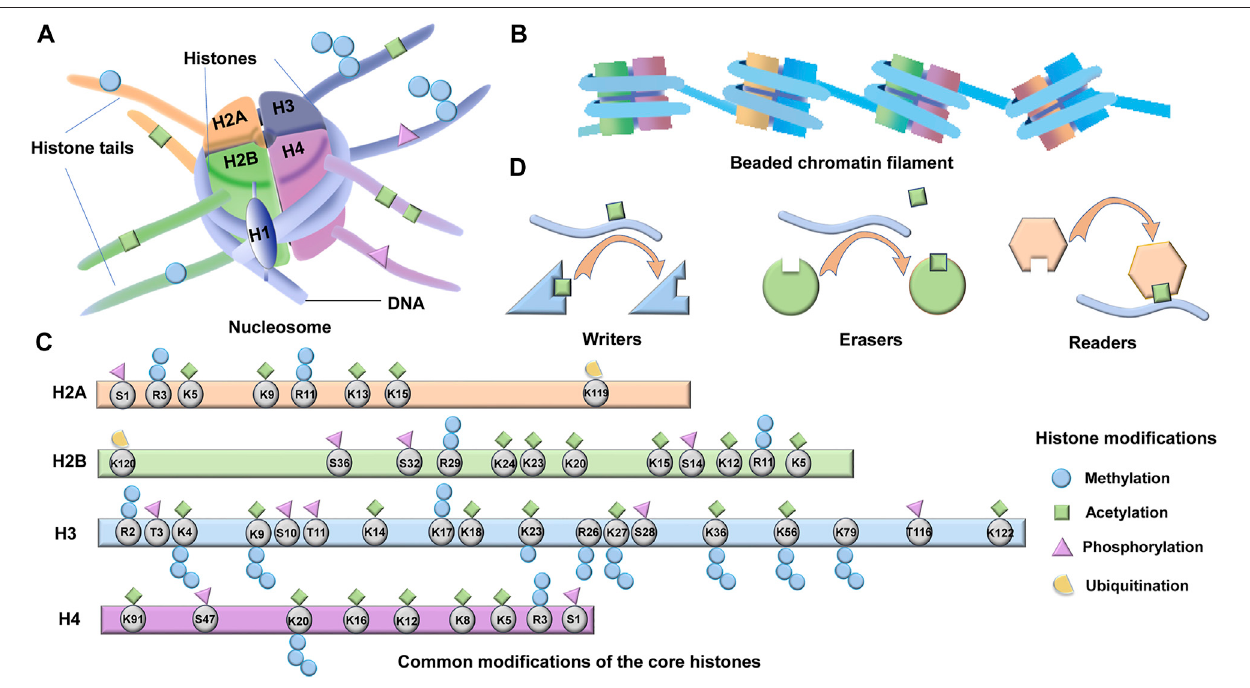
FIGURE1| Structureandmodi fi cationsofhistones. (A) Fourcorehistoneproteins(H2A,H2B,H3,andH4)andonelinkerhistoneH1whichbindstothesitewhere DNA enters and exits the nucleosome core particle, form a complete nucleosome. Post-translational modi fi cations (PTMs) occur on histone terminal tails, which are accessible on the surface of the nucleosome. (B) The nucleosomes are linked by a sequence of DNA ( ∼ 60 bp) and are assembled into beaded chromatin fi laments. (C) The potential acetylation, methylation, phosphorylation, and ubiquitination sites of the four core histones are shown. (D) A large array of proteins are involved in regulating and interpreting these PTMs, including readers, writers, and